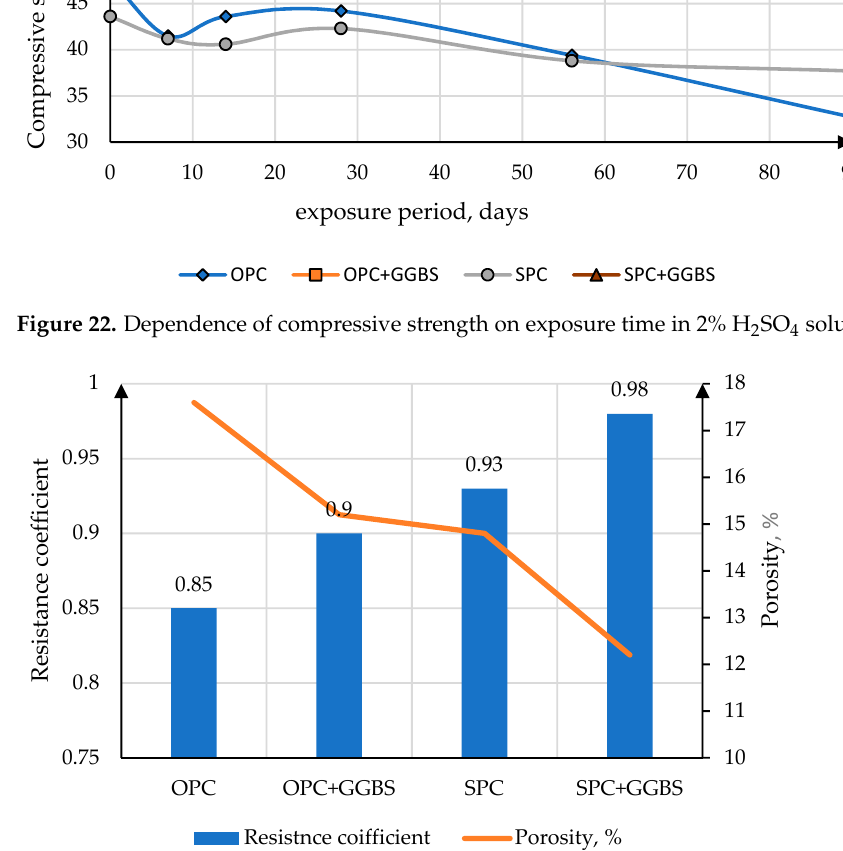
Figure 23. Resistance coefficient and porosity of samples exposed in a sulfate medium for 3 months.